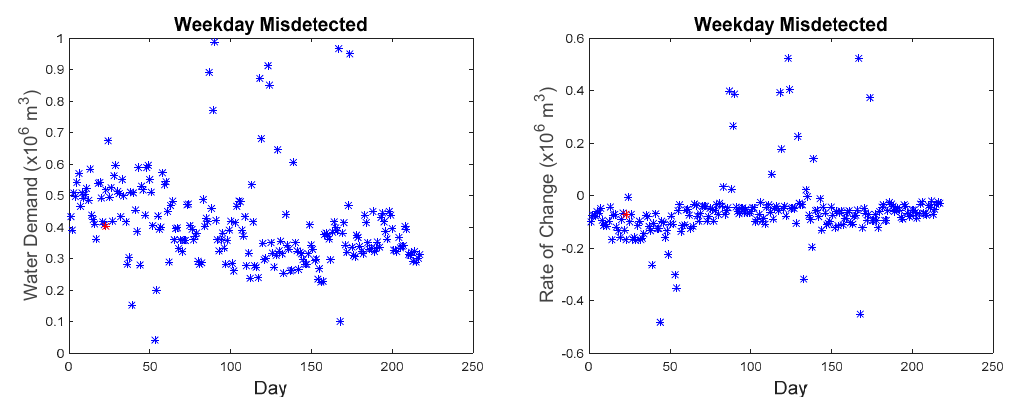
Figure 20. Comparison of third missed detected anomaly with other points.